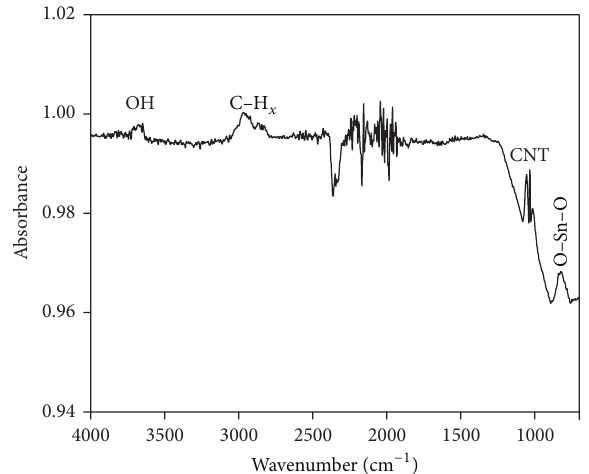
Figure 6: Characteristic attenuated total reflectance: Fourier trans- form infrared spectra of SnO 2 -CNT